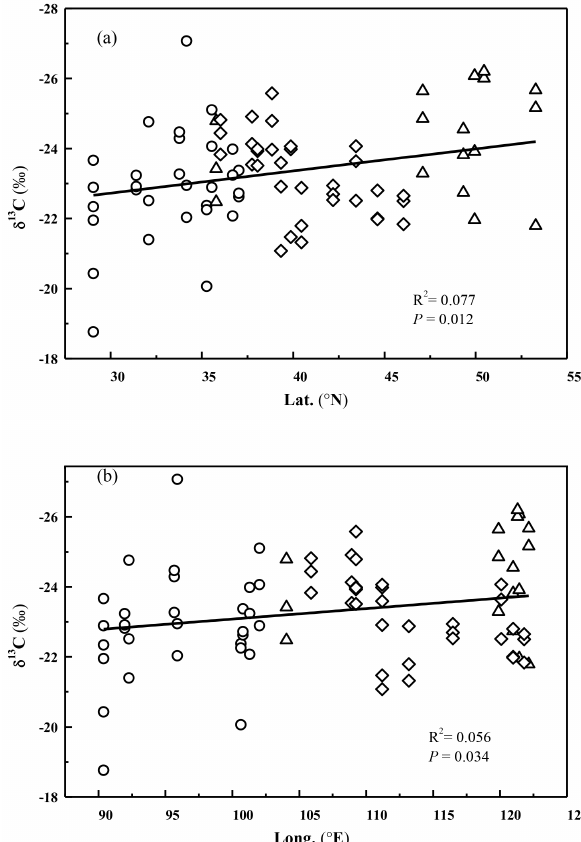
Figure 4. Shows the relationships between the soil δ 13 C and lati- tude (a) and longitude (b) .